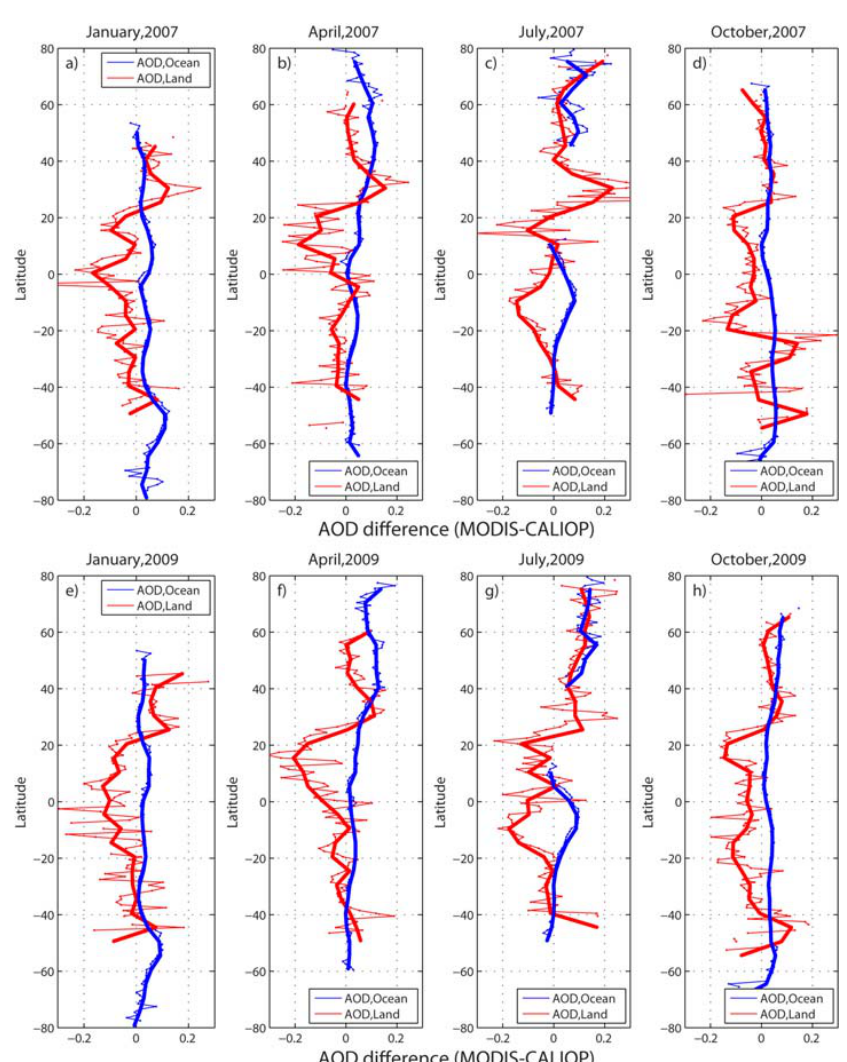
Fig. 6. Latitudinal distribution of the mean difference between MODIS and CALIOP V3 AOD (using comparison #3 screening from Table 1) over-ocean (blue lines) and over-land (red lines), with thin lines representing 1-degree averages and thick lines indicating 5-degree averages, for all 8 months considered in this